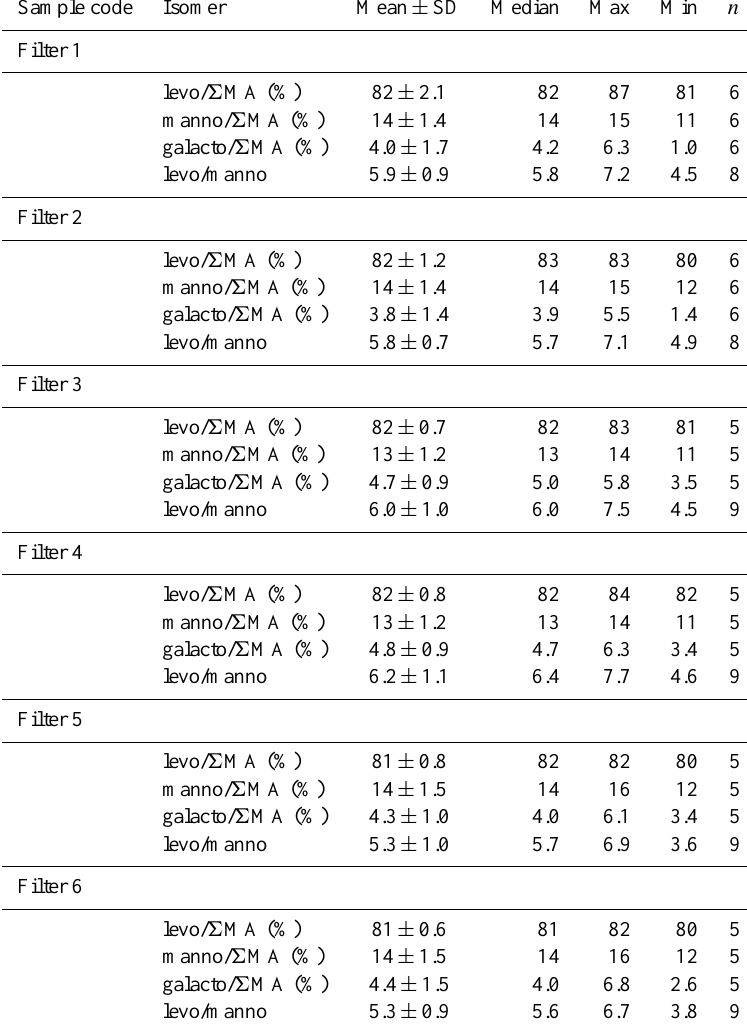
Table B4. Calculated mean ( ± SD) and median ratios, as well as maximum and minimum ratios of levoglucosan (levo), mannosan (manno) and galactosan (galacto), to the sum of the three isomers ( (cid:54) MAs) including the mannosan to levoglucosan ratio in the six filter samples subjected to the intercomparison, as obtained by the various methods applied. Number of values included in the calculated values are listed. Outliers and values BDL are not included in the calculated concentrations, nor in the listed maximum and minimum